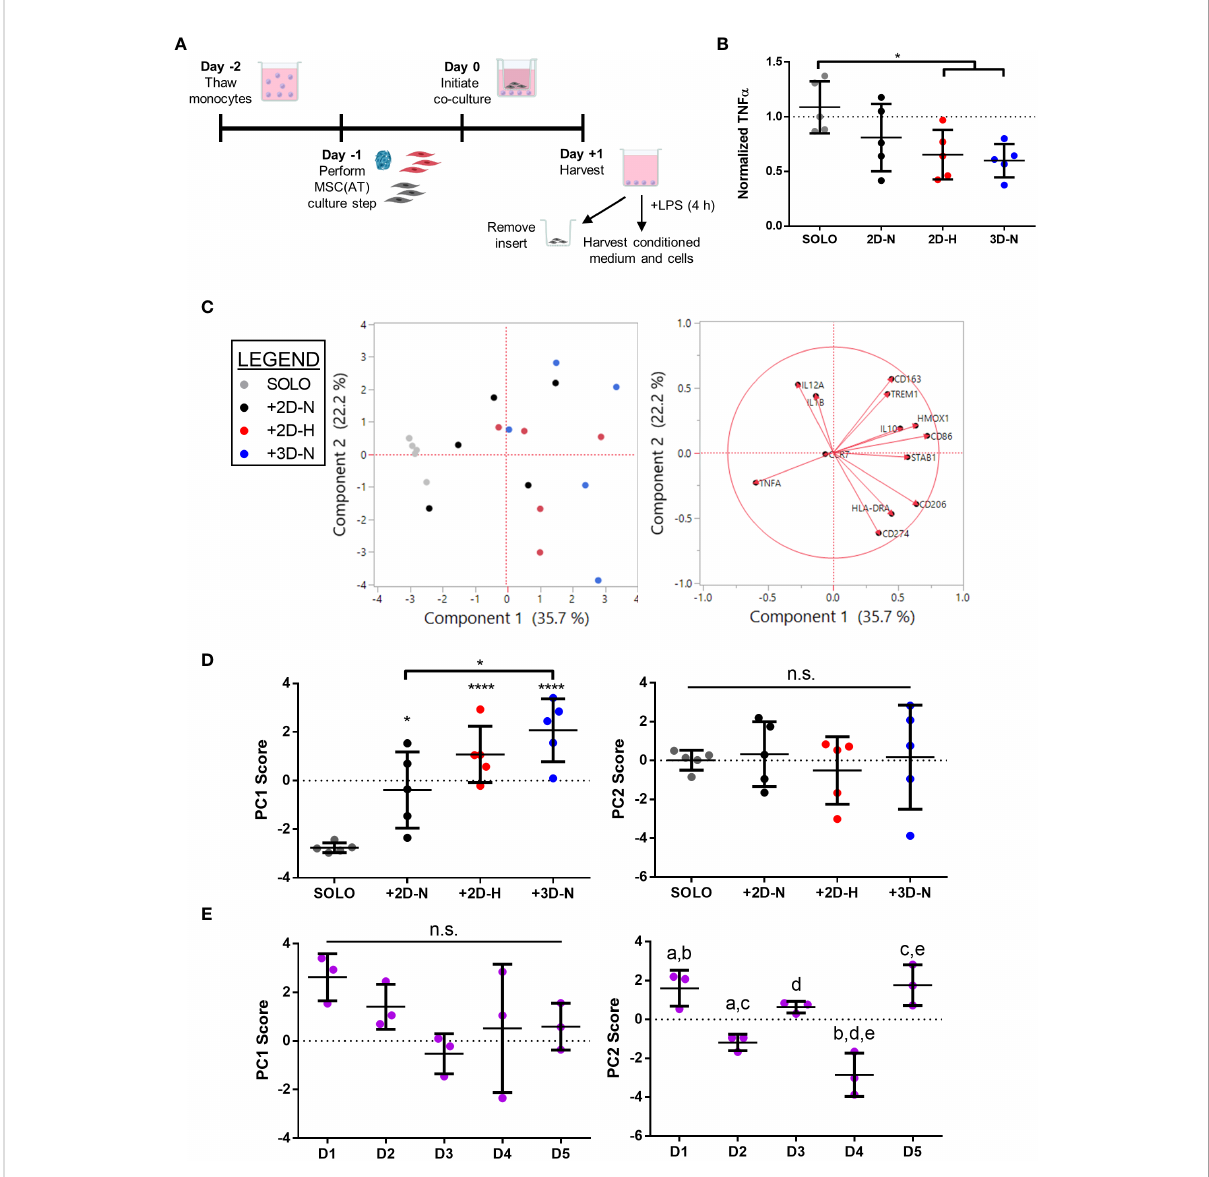
FIGURE 4 In vitro MSC(AT)-mediated functional polarization of M F was differentially sensitive to donor heterogeneity and select CPPs. (A) Schematic of indirect co-culture experiment. MSC(AT) (2D-N, 2D-H, or 3D-N culture conditions) were co-cultured with human peripheral blood-derived monocytes/macrophages (M F ) for 24 h prior to removal of MSC(AT) and addition of lipopolysaccharide (LPS). (B) TNF a secretion, a surrogate marker for pro-in fl ammatory M F s, showed signi fi cant reduction when co-cultured with 3D-N or 2D-H MSC(AT) compared to solo M F s. One- way ANOVA, Tukey post-hoc test. *p<0.05. (C) Principal component (PC) analysis of median delta-delta Ct values of M F genes, indicative of pro-in fl ammatory ( CCR7 , CD86 , HLADRA , IL12A , IL1B , TREM1 ) or pro-resolving ( CD163 , CD206 , HMOX1 , IL10 , CD274 , STAB1 ) status, and normalized TNF a levels from each donor and culture condition (left). The corresponding loading plot of eigenvectors for each marker (right) indicates the relative contribution of each factor to the PCs. (D) Principal component scores for PC1 and PC2 according to culture condition. PC1 scores were highest in the 3D-N co-culture condition. One-way ANOVA, Tukey post-hoc test. *p<0.05, ****p<0.0001 relative to M F SOLO condition or to groups indicated by brackets. (E) Principal component scores for PC1 and PC2 according to MSC(AT) donor heterogeneity. Statistically signi fi cant differences between groups were observed in PC2 scores and are indicated by groups sharing the same letter. One-way ANOVA, Tukey post-hoc test, p<0.01. N=5 MSC(AT) donors, n=3 technical replicates/condition. Horizontal bars: group mean, error bars: standard deviation. 3D-N, 3D Normoxic culture; 2D-N, 2D Normoxic culture; 2D-H, 2D Hypoxic culture; n.s., statistically non-signi fi